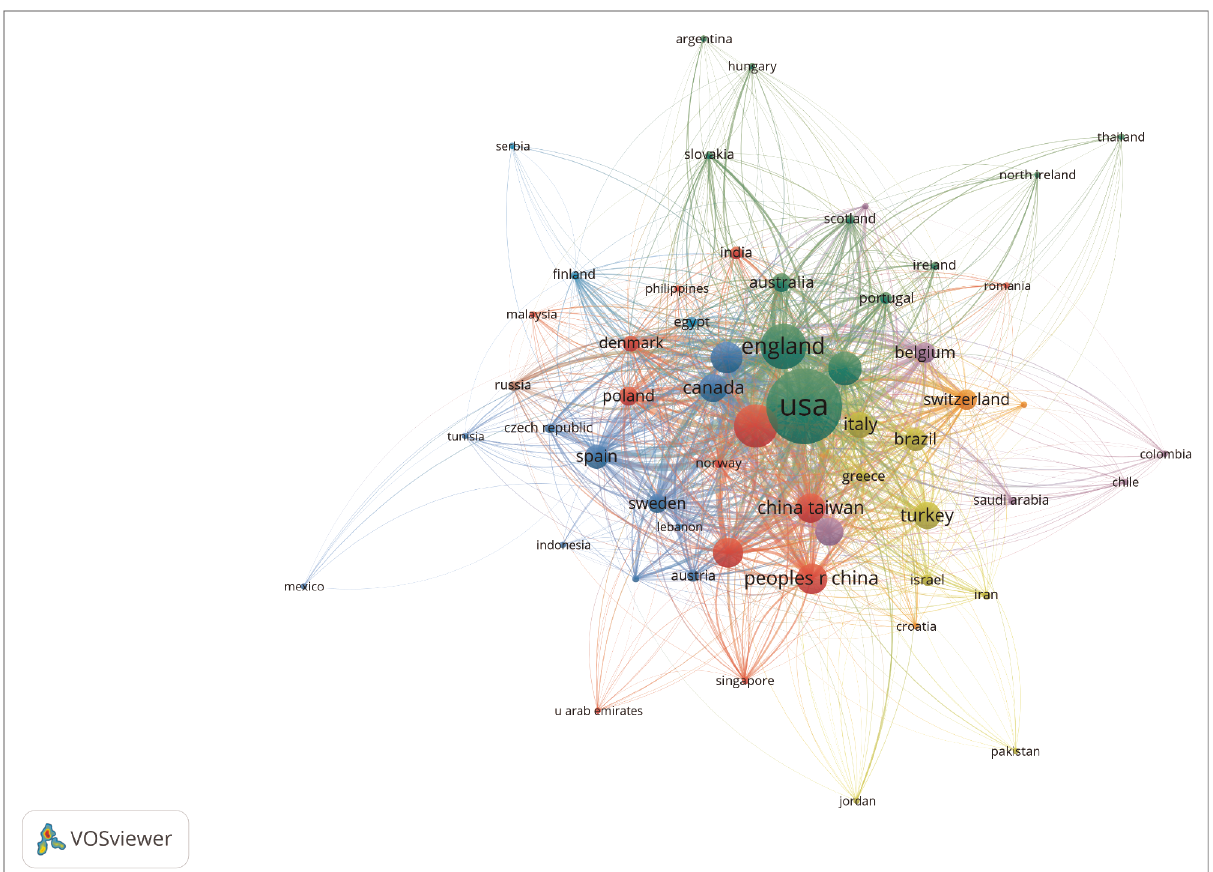
FIGURE 5 Network map illustrating international research collaborations between countries in original human studies on overactive bladder; the size of circles reveals the number of